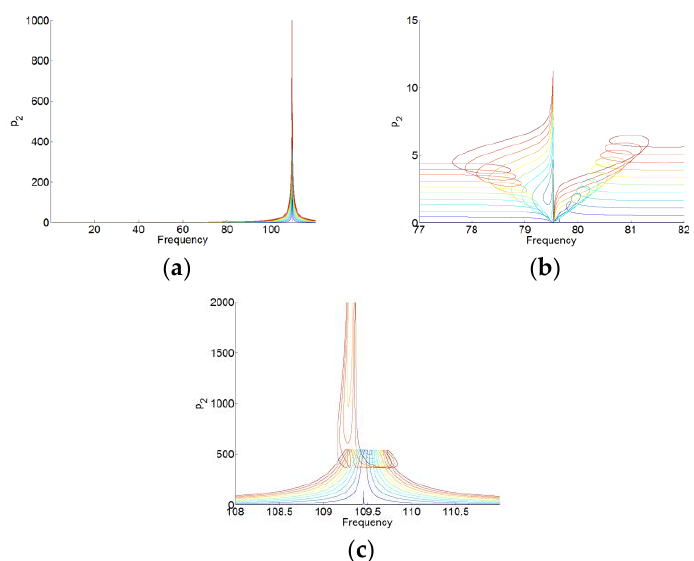
Figure 12. ( a ) Responses of 𝑝 2 (𝑡) for 𝐹 1 = [0.01:2:20.01] . ( b , c ) are the zooms of ( a ) around two resonant frequencies of the cavity.